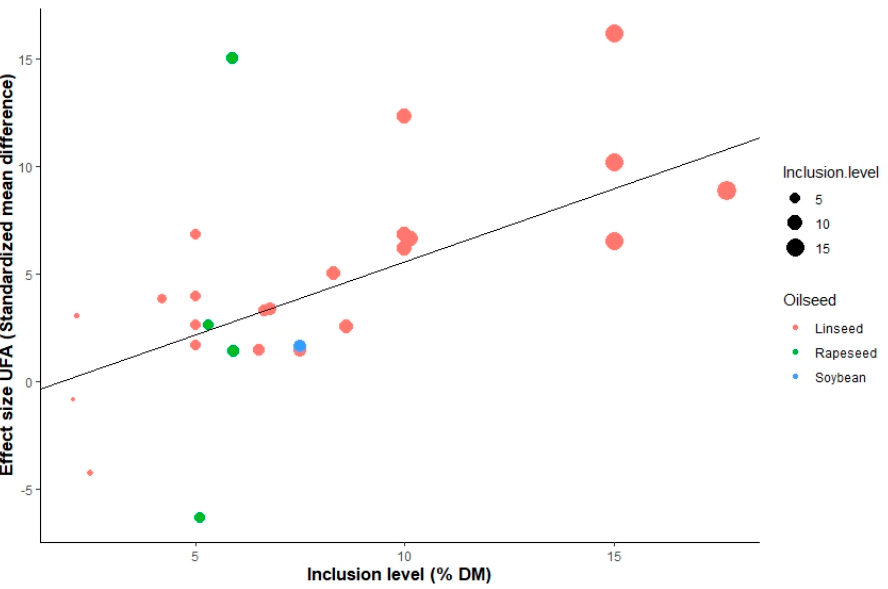
Figure 6. Bubble plot of UFA (g 100 g − 1 FA) of the raw mean difference. Inclusion level of oilseeds is represented by the size of the point with the value to the left (%); the color of the point indicates the type of oilseed.